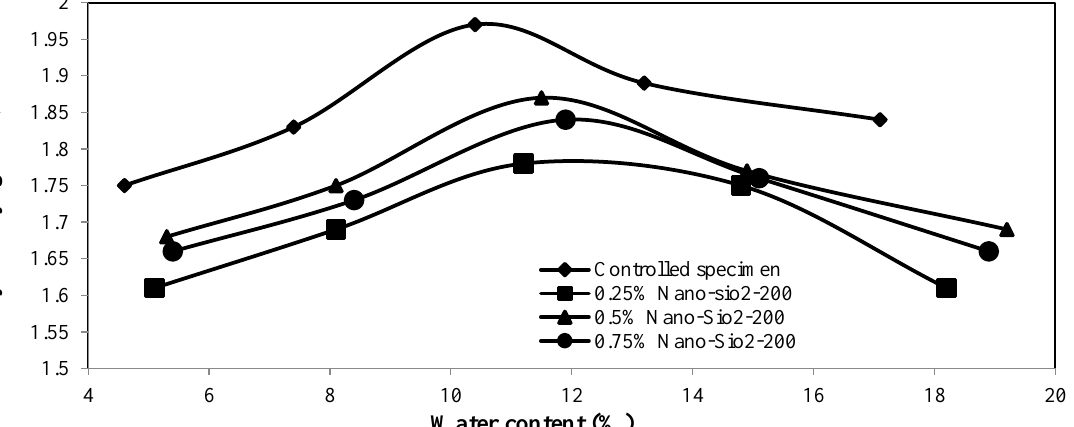
Fig. 7. The effect of nanosilica 200 content on the dry density and optimum moisture